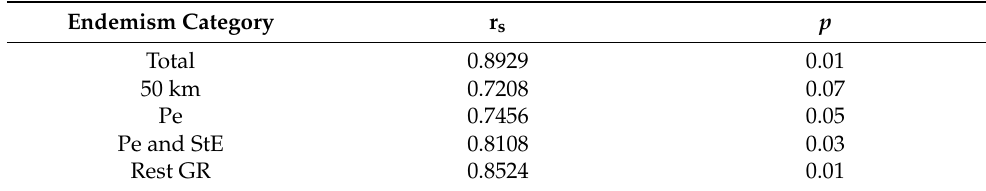
Table 2. Results of Spearman’s rank correlation computed to assess the relationship between maxi- mum elevation of Mts. Erimanthos, Panachaiko, Chelmos, Saitas, Oligirtos, Killini, and Farmakas and the number of Greek endemics (Total), narrow endemics (50 km), Peloponnisos endemics (Pe), Peloponnisos and Sterea Ellas endemics (Pe and StE), and endemics with a wider distribution in Greece (Rest GR) recorded on each mountain. r s : rho coefficient, p : probability. Endemism Category r s p Total 0.8929 0.01 50 km 0.7208 0.07 Pe 0.7456 0.05 Pe and StE 0.8108 0.03 Rest GR 0.8524 0.01